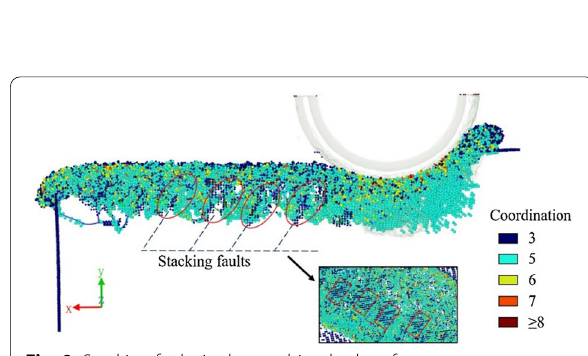
Fig. 8 Stacking faults in the machined